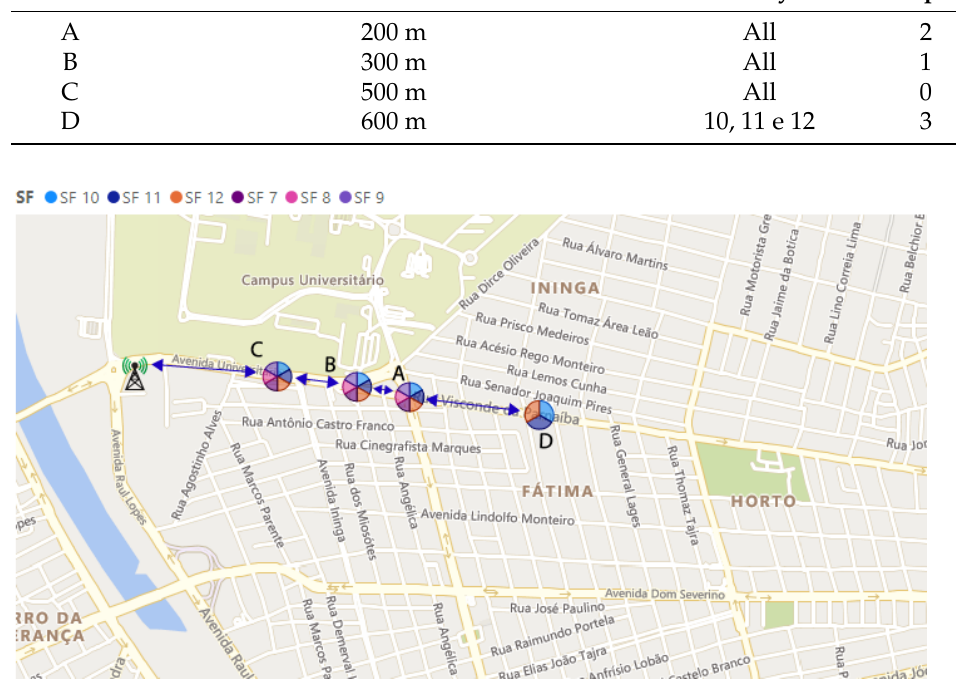
Figure 24. Endode positions in the real scenario in LoRaMESH